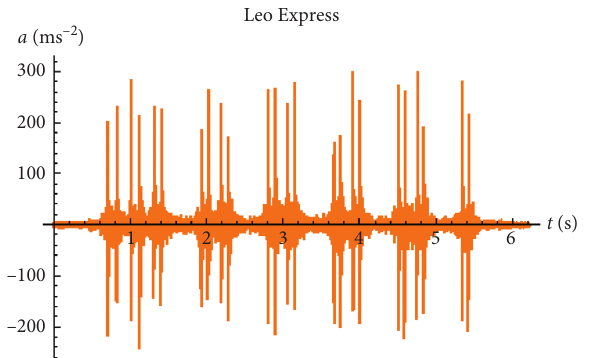
Figure 3: Acceleration plot of the bearer under the crossing nose.